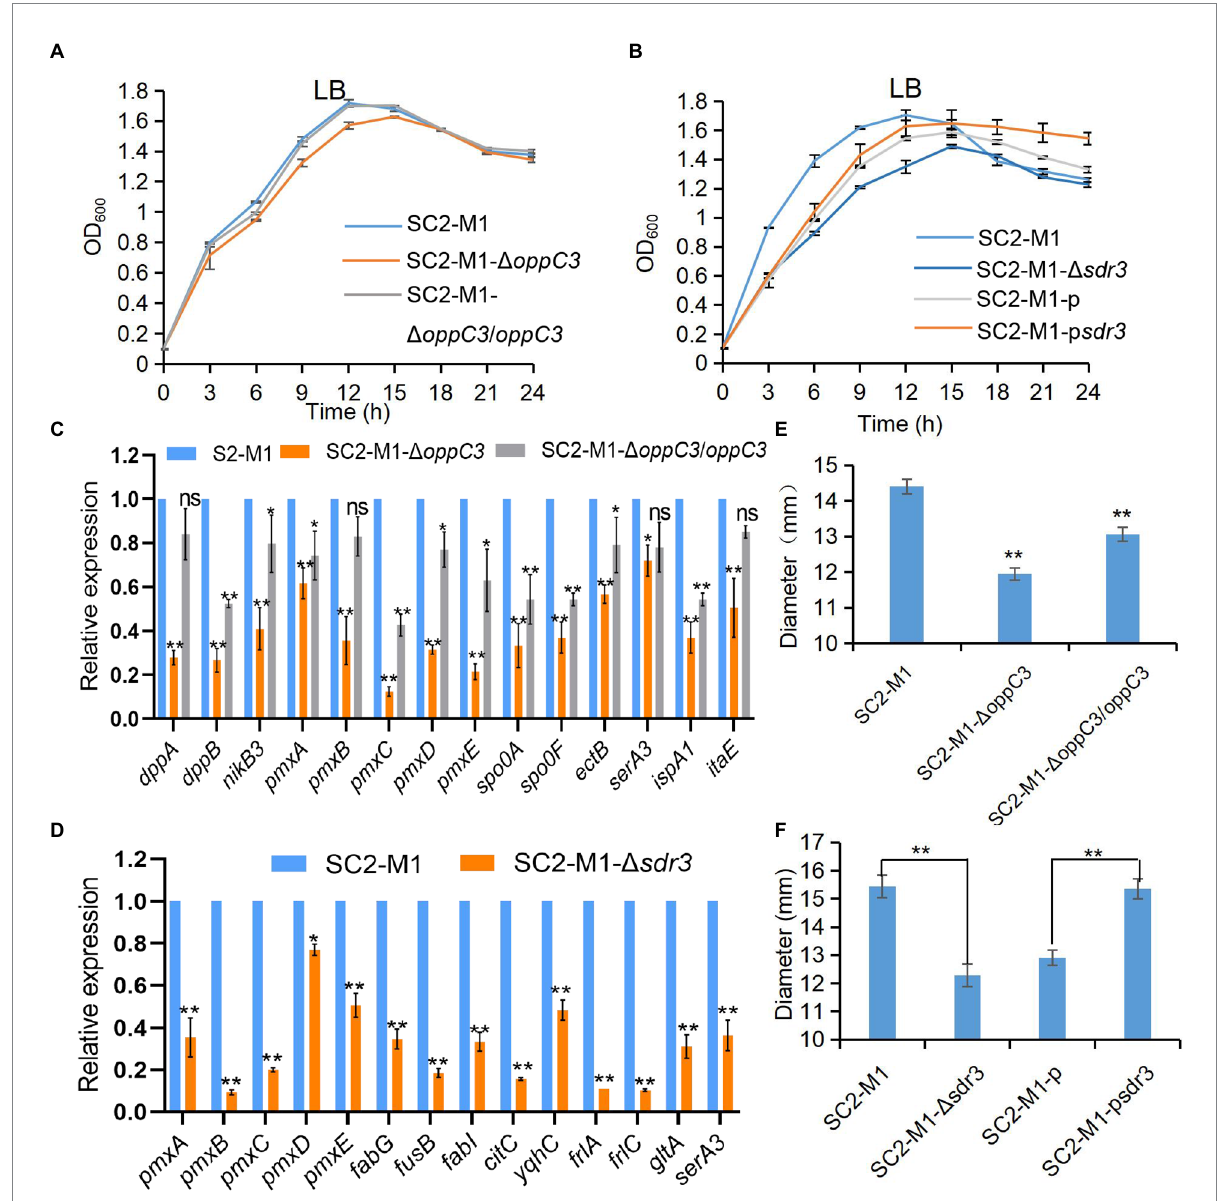
FIGURE 4 MsmR1 regulates polymyxin synthesis by directly binding to oppC3 and sdr3 promoters. (A) Growth curves of SC2-M1, SC2-M1- Δ oppC3 , and SC2-M1- Δ oppC3/oppC3 in LB medium at a wavelength of 600 nm. (B) Growth curves of SC2-M1, SC2-M1- Δ sdr3 , SC2-M1-p, and SC2-M1-p sdr3 in LB medium detected at a wavelength of 600 nm. (C) Relative expression of genes related to polymyxin synthesis gene cluster and amino acid transport and metabolism ( dppA , dppB , ectB , serA3 , ispA1 , and itaE ) in strain SC2-M1 and SC2-M1- Δ oppC3 by qRT-PCR assay. (D) Gene expression related to polymyxin synthesis, amino acid metabolism ( gltA , serA3 ), fatty acid metabolism ( fabG , fabI , fusB ) in strains SC2-M1 and SC2-M1- Δ sdr3 . (E) Inhibition zone of the SC2-M1, SC2-M1- Δ oppC3 , and SC2-M1- Δ oppC3 / oppC3 strains. (F) Inhibition zone of the SC2-M1, SC2-M1- Δ sdr3 , SC2- M1-p, and SC2-M1-p sdr3 strains. * p < 0.05, ** p < 0.01 and ns, p >